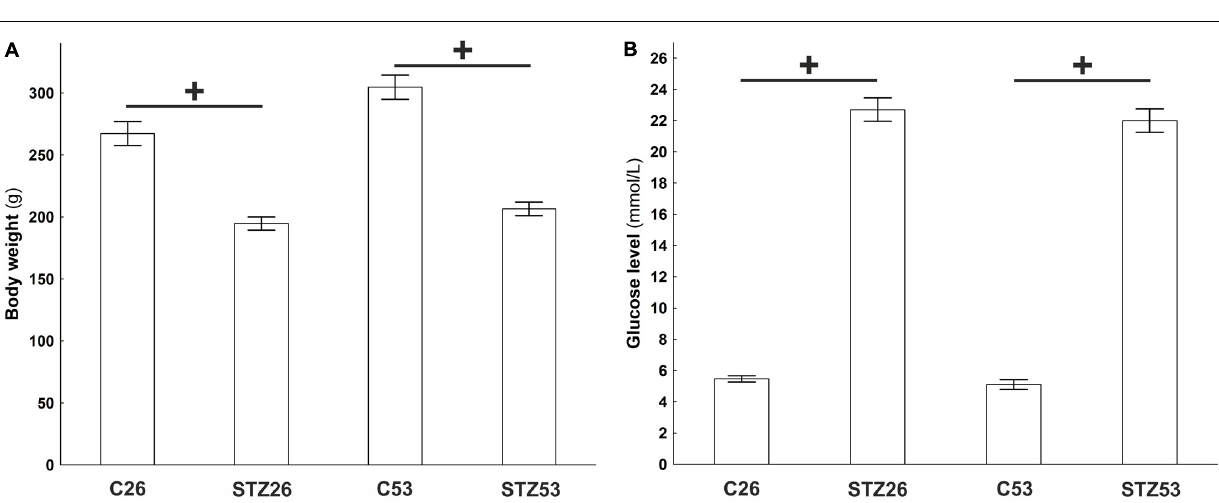
FIGURE 7 | Laser-assisted microdissection. RT-PCR detection of mRNA for NK1 receptor (NK1R) and β -actin (control gene) in picked samples of cardiomyocytes (CM; N = 4), smooth muscle cells (SMC; N = 6), and intracardiac neurons (ICN; N = 5). Agarose gel electrophoresis of PCR products for β -actin (98 bp) and NK1R (329 bp).